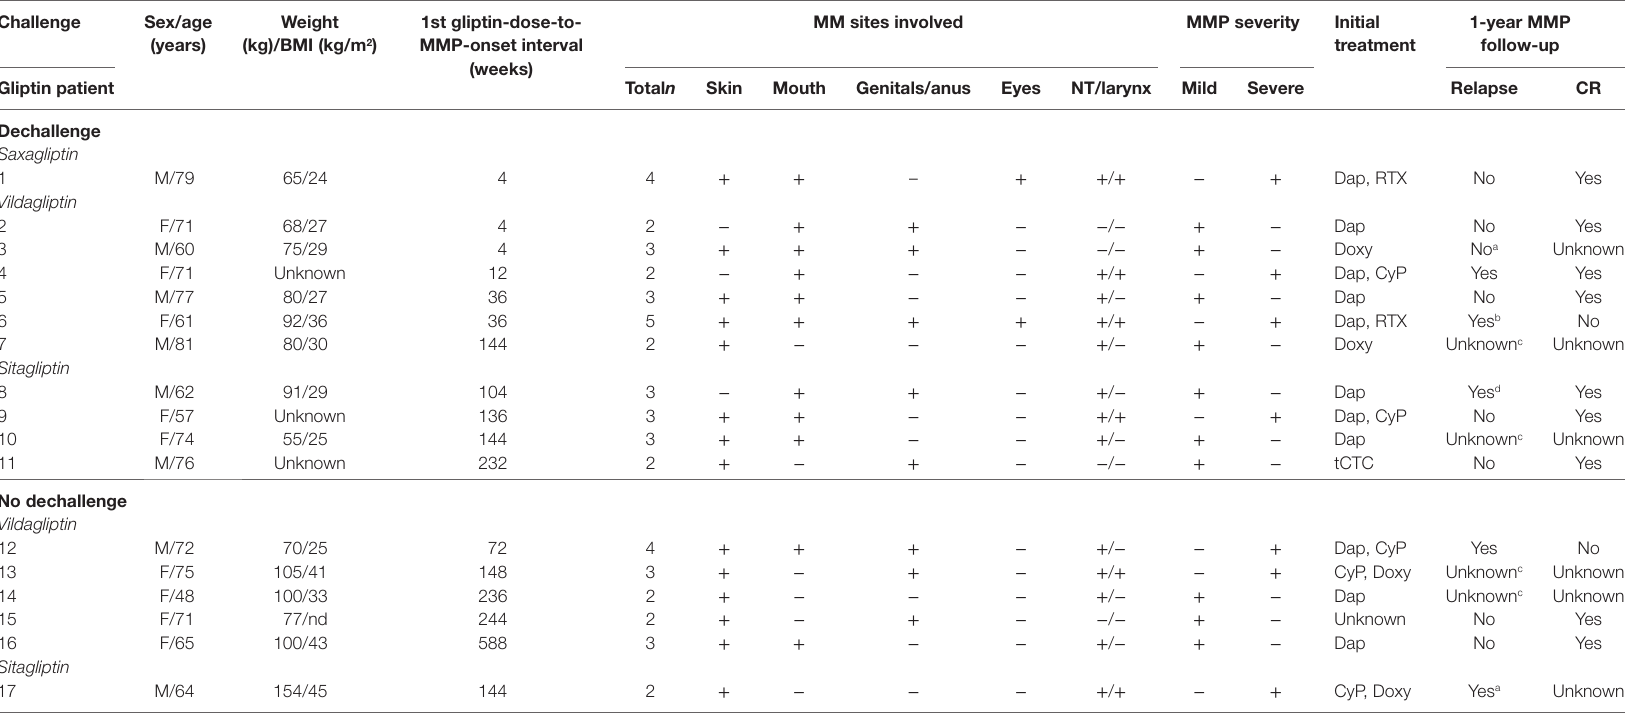
Table 1 | Clinical characteristics of the 17 MMP patients with suggestive-or-compatible gliptin challenges. challenge